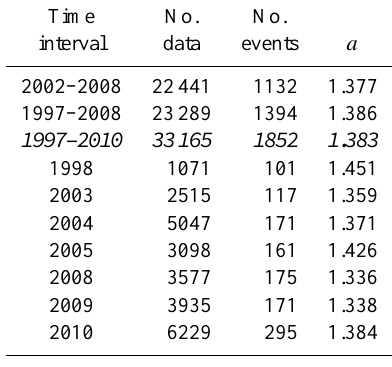
Table 1. Different sub-set results for parameter a in Eq. (6). In the first column the time period is indicated, in the second one the num- ber of amplitude data points in the time period is indicated, in the third column the number of the earthquakes providing amplitude data is written, and finally in the fourth column the corresponding value of a is written. Italic numbers in the third row are calculated from the entire data set and represent the end results of the study.